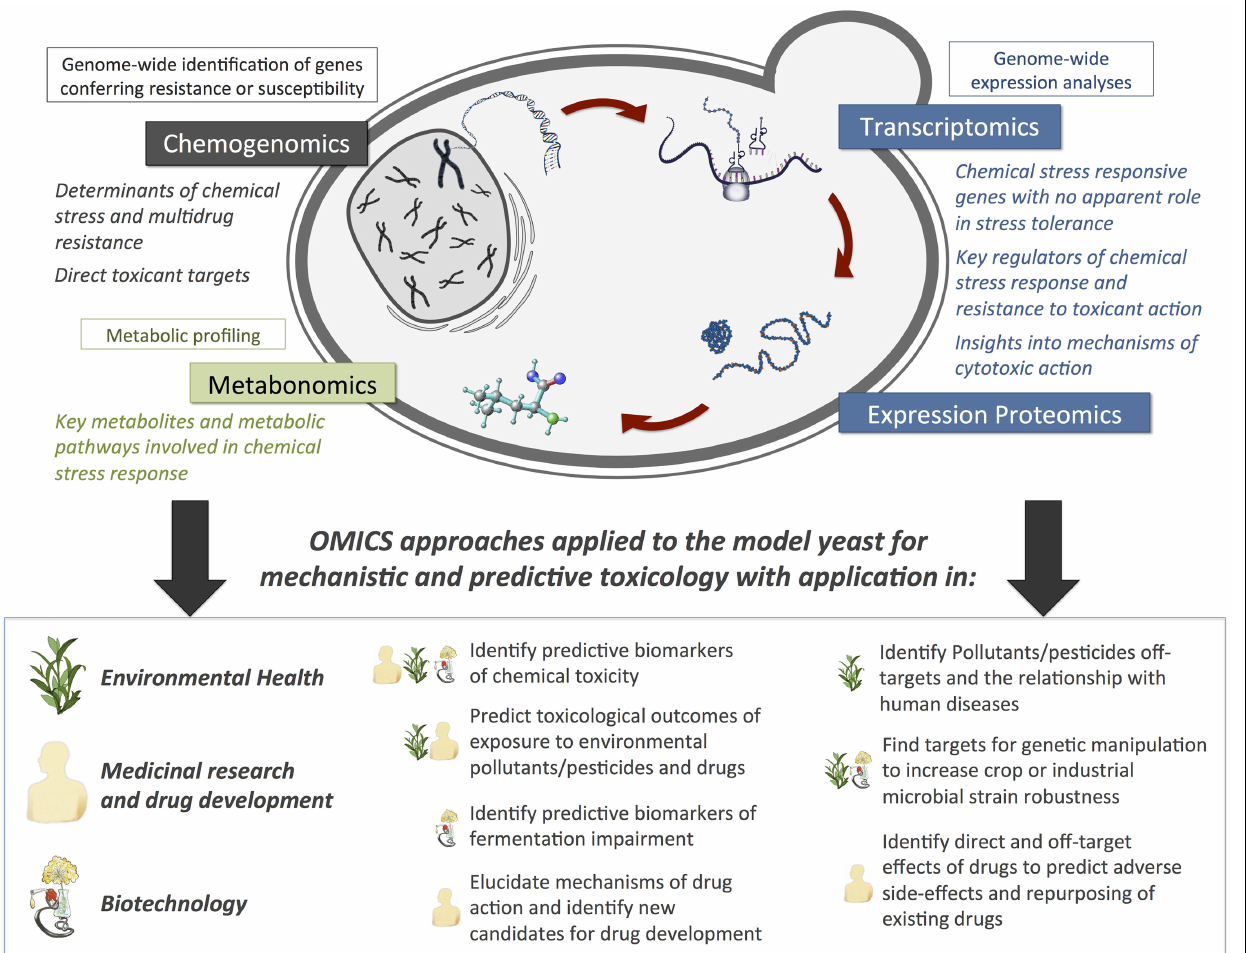
Frontiers in Genetics